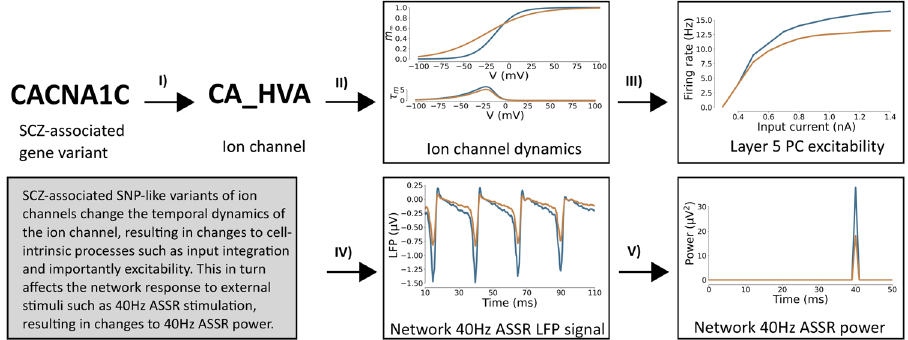
Fig. 1 Overview of the effect of genetic variants. Schematic of the cascade of effects from SCZ-associated SNP-like variants changing ion channels (I) to changes in the temporal dynamics of the ion channel (II) to altered excitability of Layer 5 pyramidal cells (III), which in turn changes network-level LFP signals in response to 40Hz ASSR input (IV) effectively changing the gamma band (40Hz) ASSR power (V). Control network depicted in blue, SCZ-associated SNP-like variant in yellow.